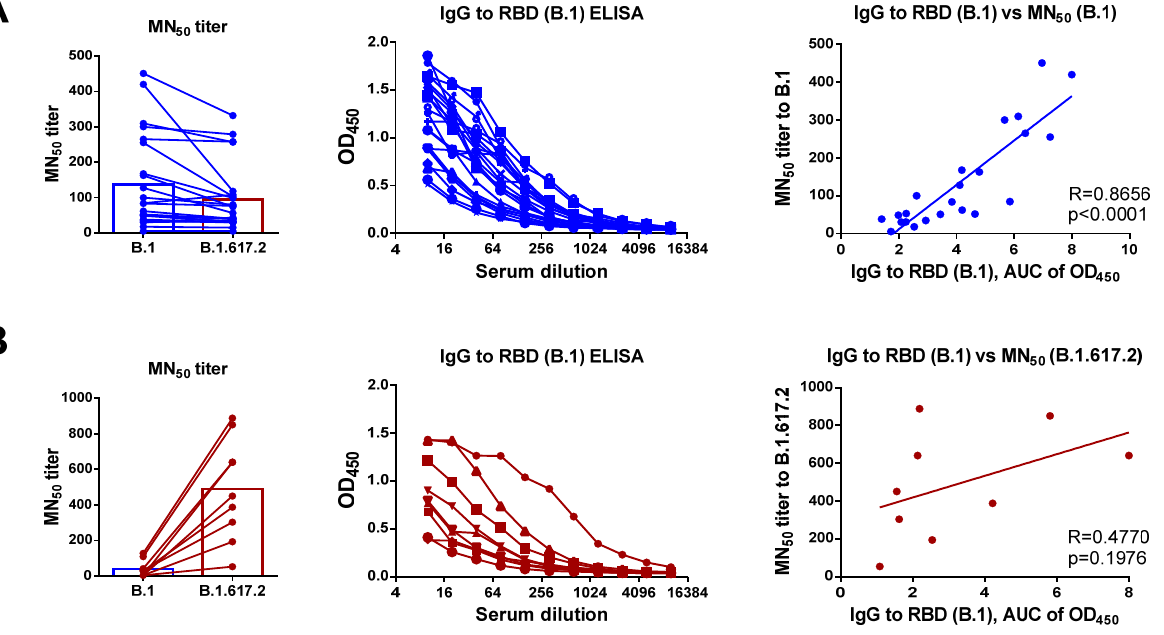
Figure 1. Characterization of virus-neutralizing and RBD-binding antibody levels in COVID-19 convalescents. Serum samples were collected from subjects who recovered from B.1 (Wuhan) SARS- CoV-2 ( A ) and B.1.617.2 (Delta) variant ( B ). Left panel shows MN 50 titers for B.1 and B.1.617.2 variants of each sample. Middle panel shows ELISA data for RBD (B.1) antigen for each participant. Right panel shows the correlation between MN 50 titers and RBD-specific IgG levels. The dataset included sera from patients who recovered from B.1 ( n = 23, blue symbols) and B.1.617.2 ( n = 9, dark red symbols) variants.